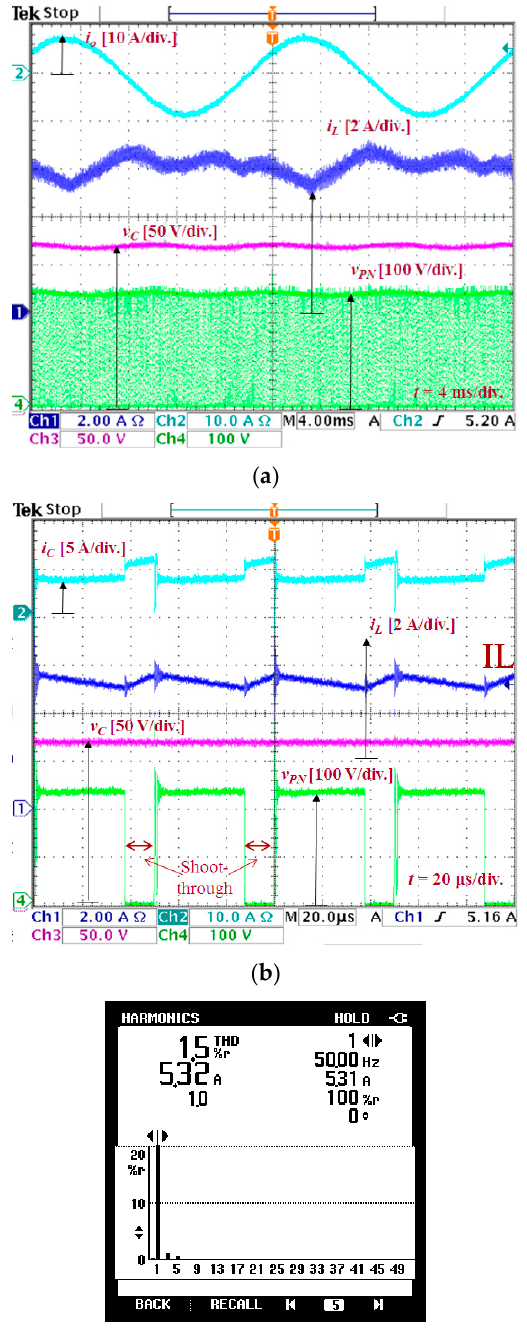
Figure 10. Experimental waveforms for a qZSI when V dc = 120 V, M = 0.75, and A = 0.01. From top to bottom: ( a ) load current, inductor current, capacitor voltage, DC-link voltage; ( b ) capacitor current, capacitor voltage, inductor current, DC-link voltage; and ( c ) load current harmonics.